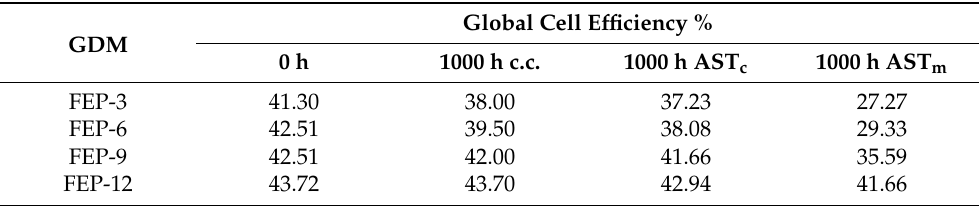
Table 3. Efficiency values calculated from polarization curves of fuel cells assembled with GDMs with increasing FEP content (3 to 12 wt.%) tested as fresh components (0 h), after constant current durability experiments (1000 h c.c.), and 1000 h of chemical (AST c ) and mechanical (AST m )